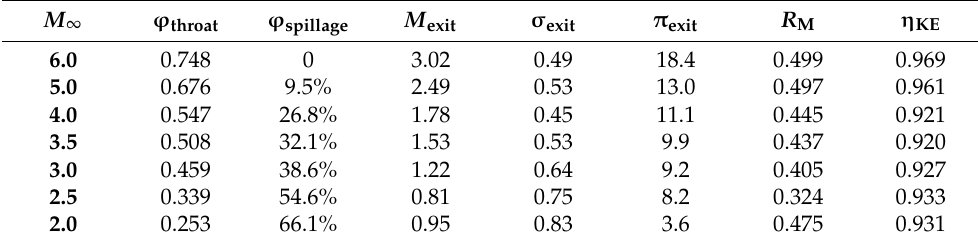
Table 3. Start-ability of the spillage-adaptive inlet.